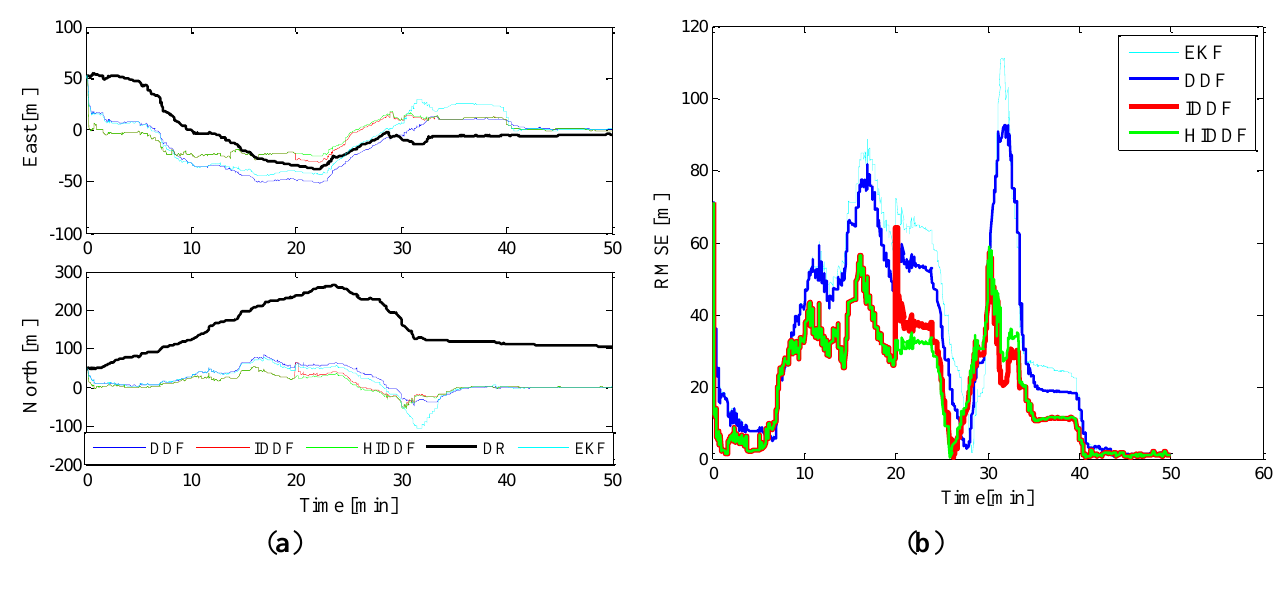
Figure 6. Simulation results in Experiment 2. ( a ) Position errors of different methods; ( b ) Position errors of EKF, DDF, IDDF and